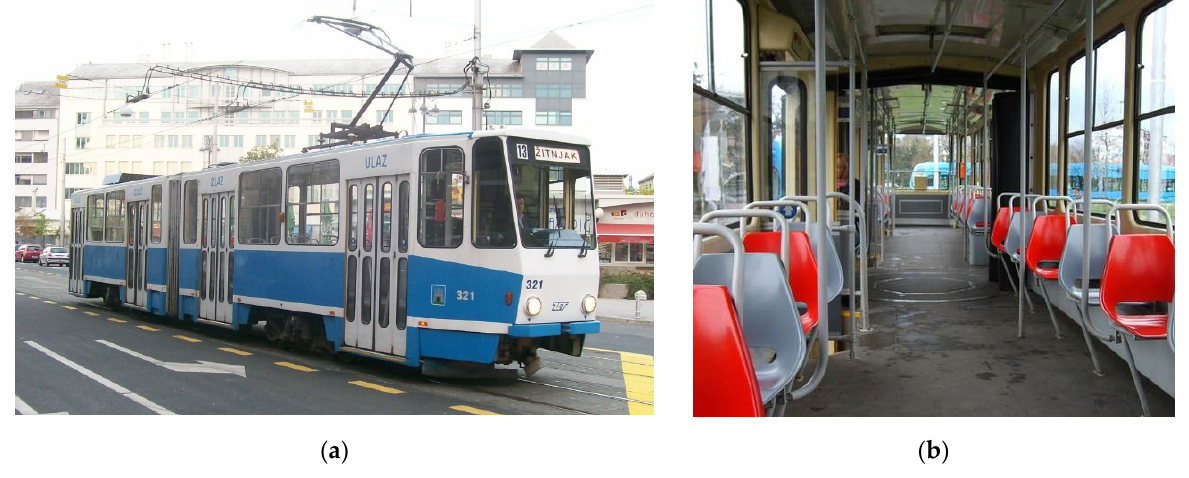
Figure 3. Tram vehicle TMK301: ( a ) exterior; ( b ) interior.